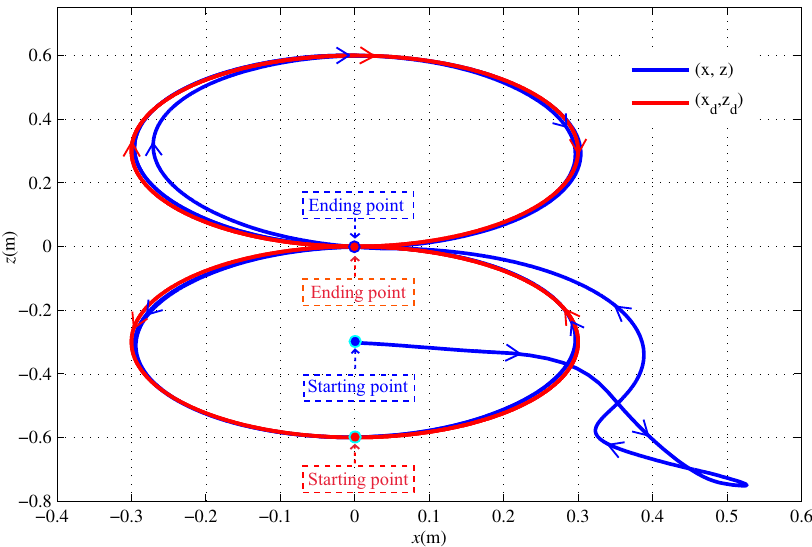
Figure 8. The trajectory tracking of the X-Z inverted